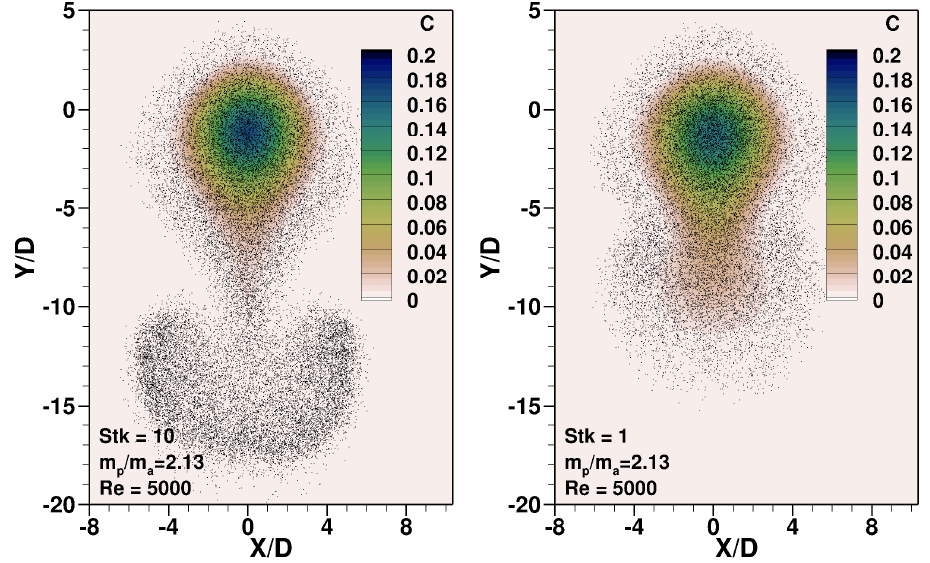
Figure 7. The counter of the continuous phase and position of the particles in Z/D = 20 section with Stokes number 1 and 10 from right to left, respectively.